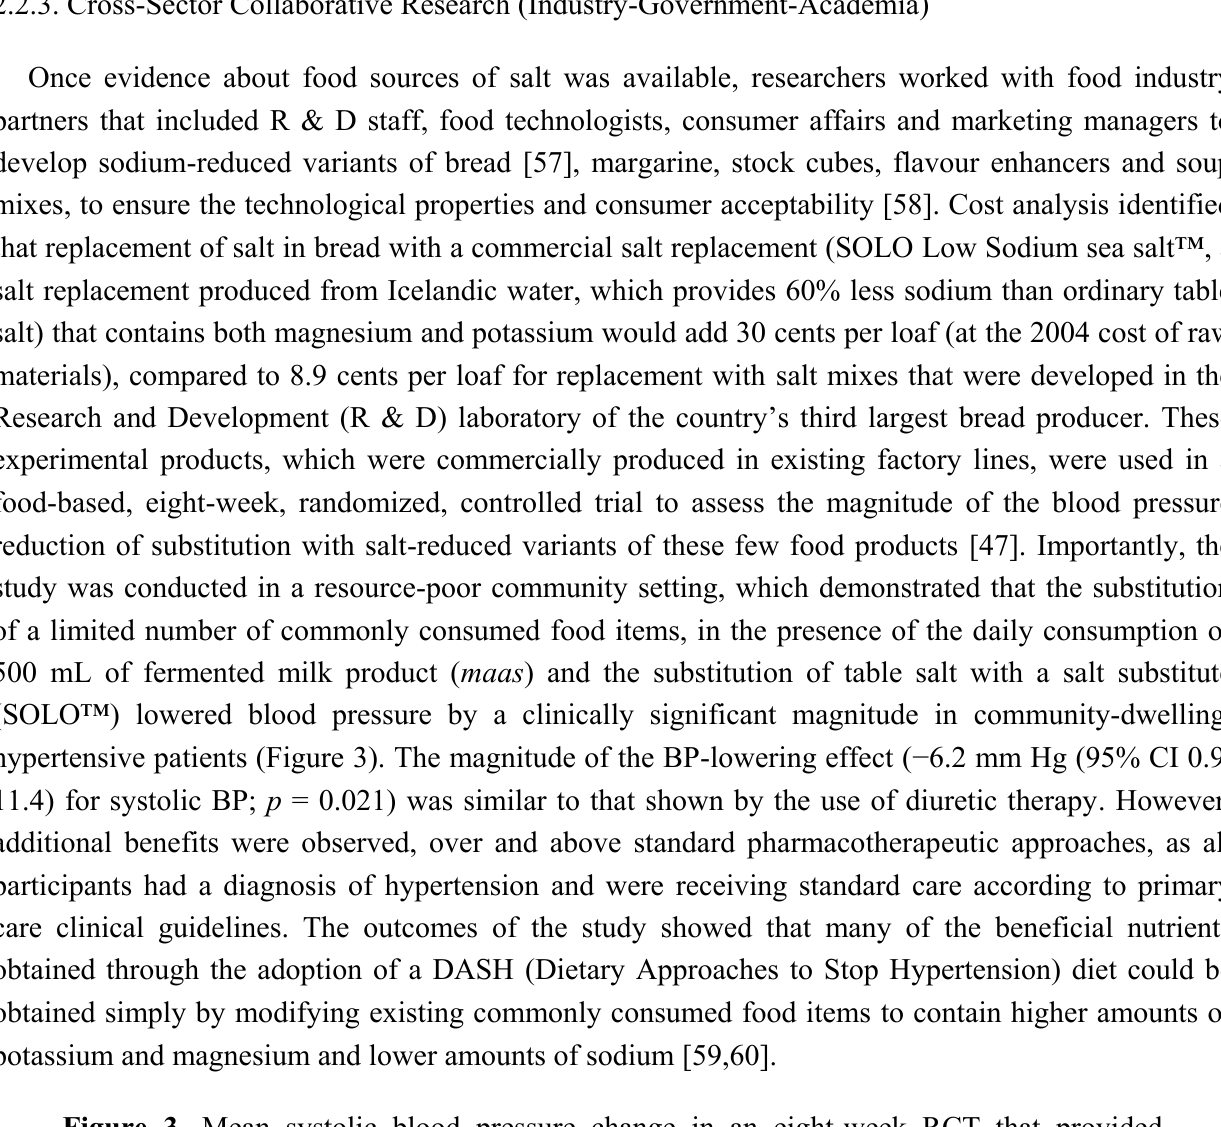
Figure 3. Mean systolic blood pressure change in an eight-week RCT that